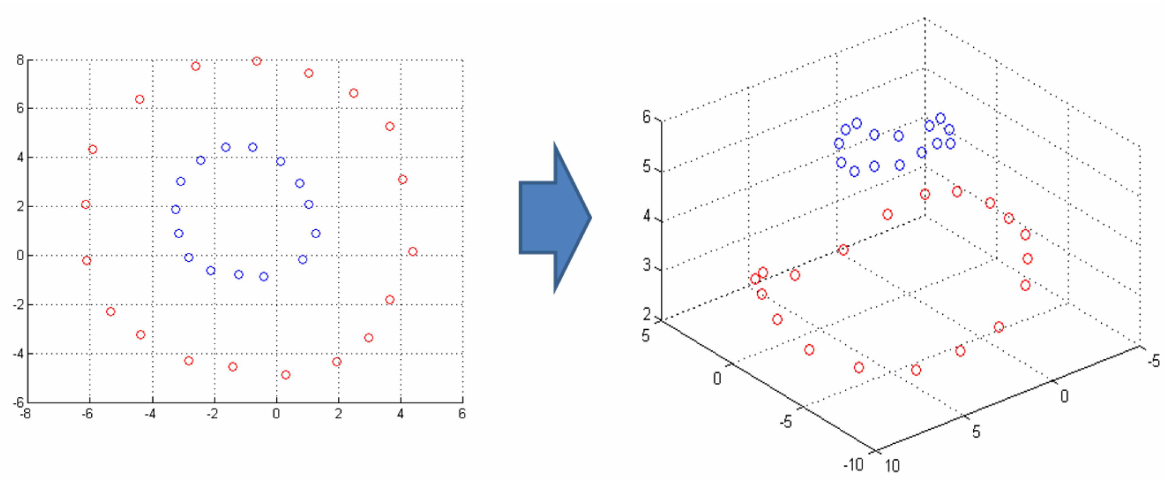
Figure 2. Input space example that is non-linearly separable (on the left). The projection of a two- dimensional data space onto a three-dimensional feature space (on the right) using the appropriate kernel renders possible data separation by a two-dimensional